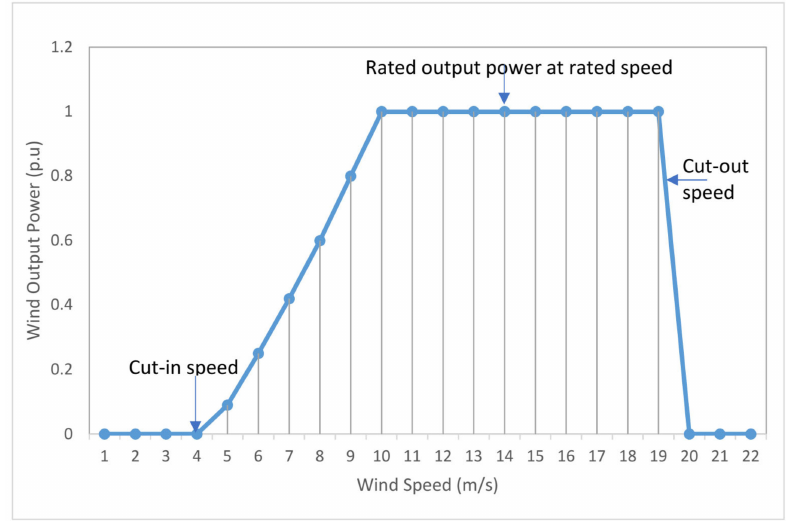
Figure 6. Characteristic curve of wind speed against mechanical output power for the studied WT